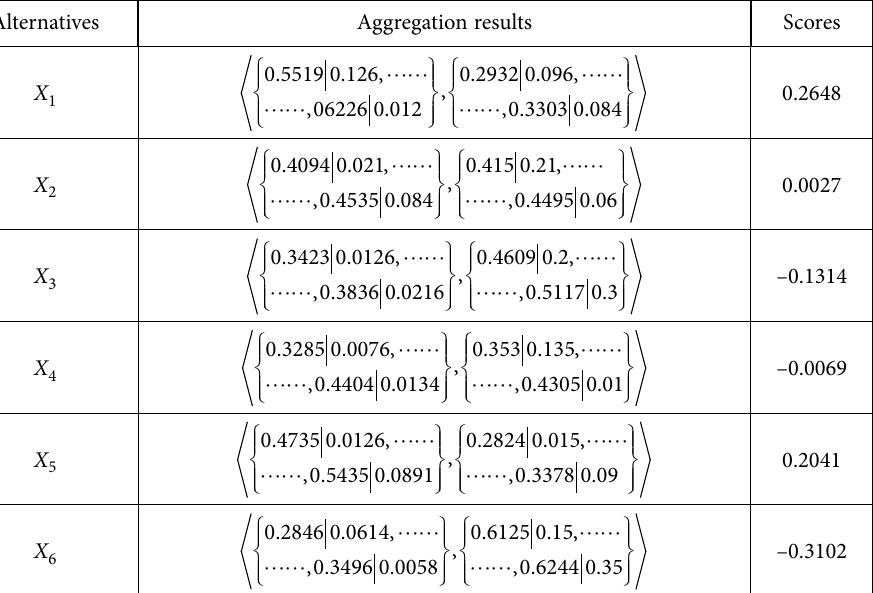
Table 16. The outcome with the PDHFWEG